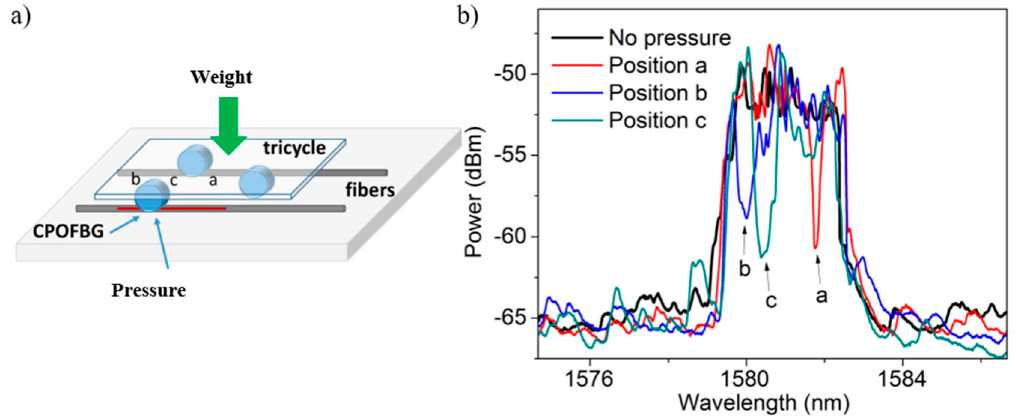
Figure 13. ( a ) Setup for applying pressure and ( b ) measured spectrum under point pressure; image adapted from [67].